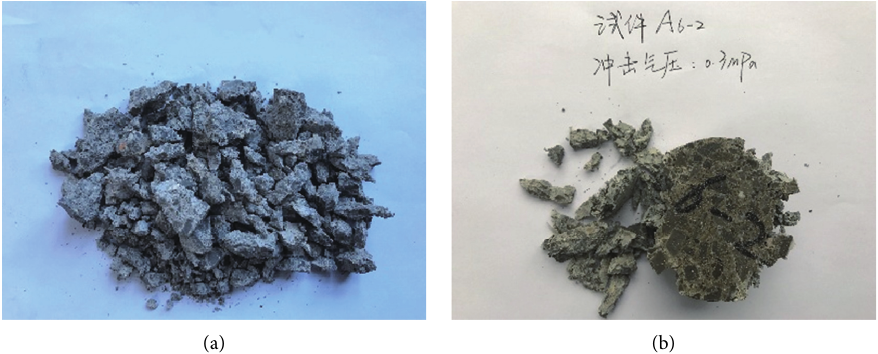
Figure 8: The failure pattern of specimens under 0.3MPa: (a) A1; (b) A6.